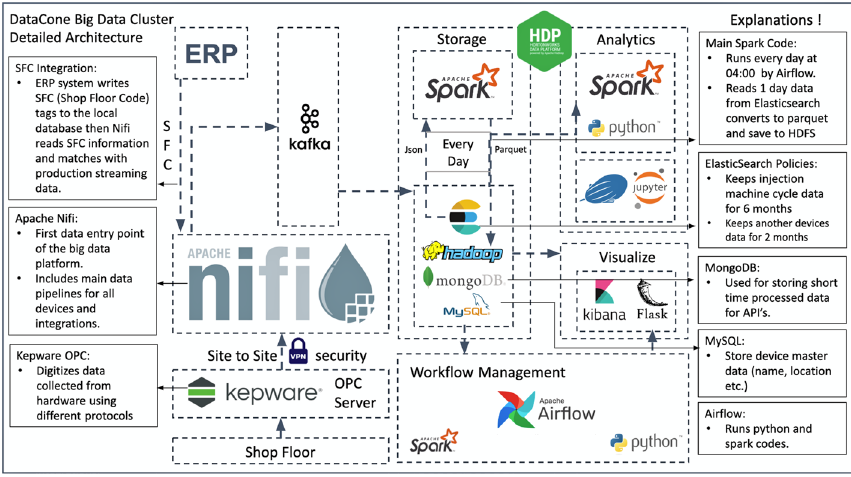
Fig. 2 Detailed architecture design of DataCone with a combination of proper open-source big data software and enterprise software which are already used by the company. DataCone’s architecture ensures seamless interaction between existing manufacturing management systems and novel big data technologies. The data flows from left to right in this architecture. The data that is produced by IoT sensors and PLCs is consumed by Kepware OPC Server and published to the cluster via proper protocols. Apache Nifi consumes this data and enriches it by combining it with the data that is stored in ERP systems. After the enrichment process, the data is pushed to the storage and analytics layers for further